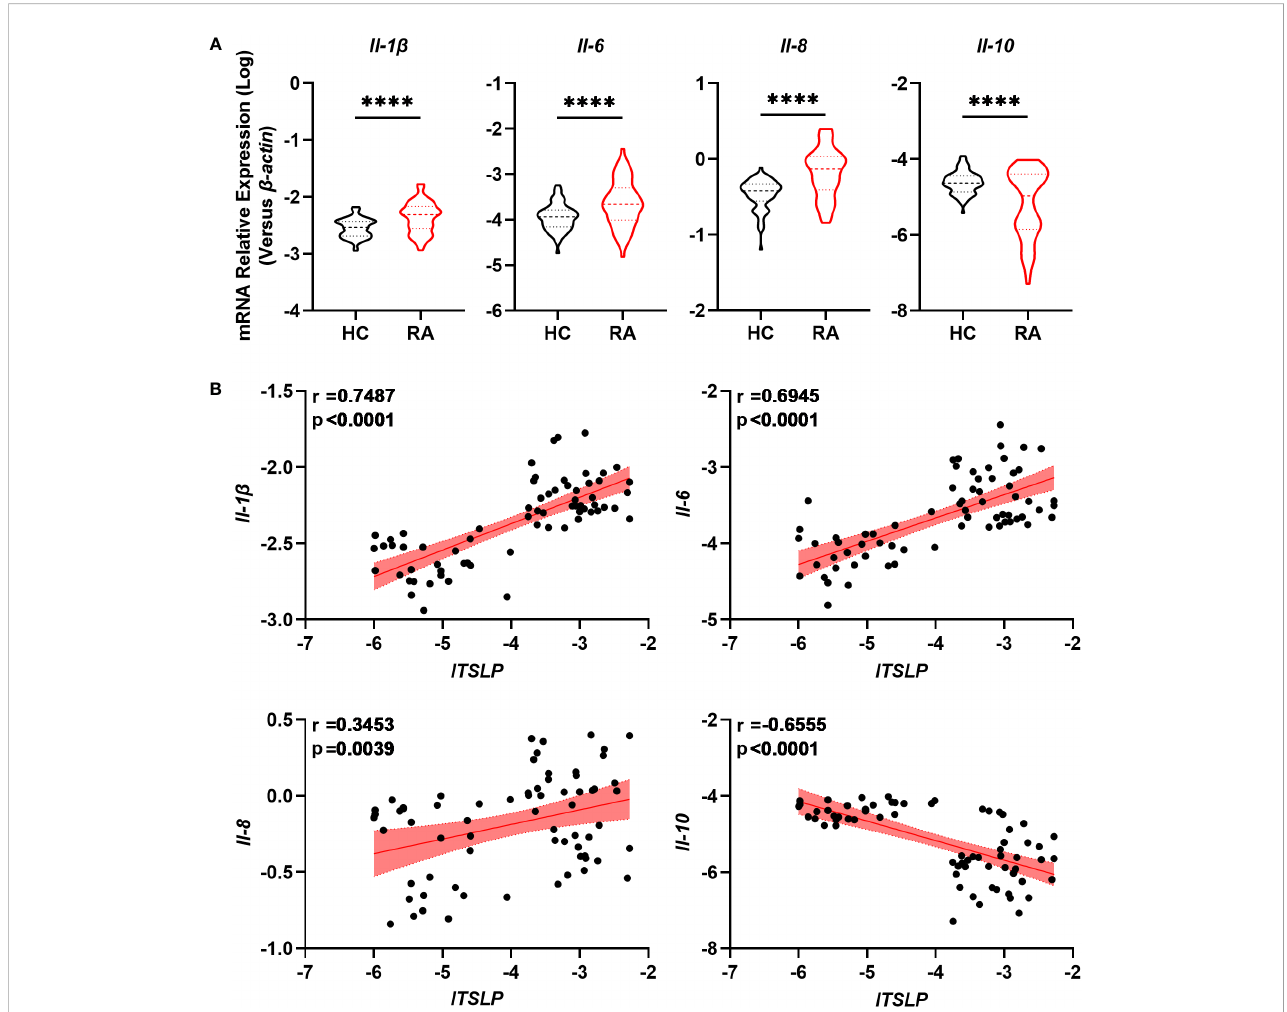
FIGURE 3 lTSLP expression in RA PBMCs correlates with pro- and anti-in fl ammatory cytokines. (A) RT-qPCR was used to detect the mRNA expression of pro- in fl ammatory cytokines IL-1 b , IL-6, and IL-8, as well as the anti-in fl ammatory factor IL-10, in PBMCs from RA patients (n = 68) and HC (n = 66). The data was depicted as a violin plot. Statistical signi fi cance was determined by unpaired two-tailed Student ’ s t-test. ****P < 0.0001. (B) Correlations between lTSLP mRNA expression and the cytokines IL-1 b , IL-6, IL-8, and IL-10 in PBMCs from RA patients. The correlations were evaluated using Spearman ’ s non-parametric test. Each symbol indicates a distinct